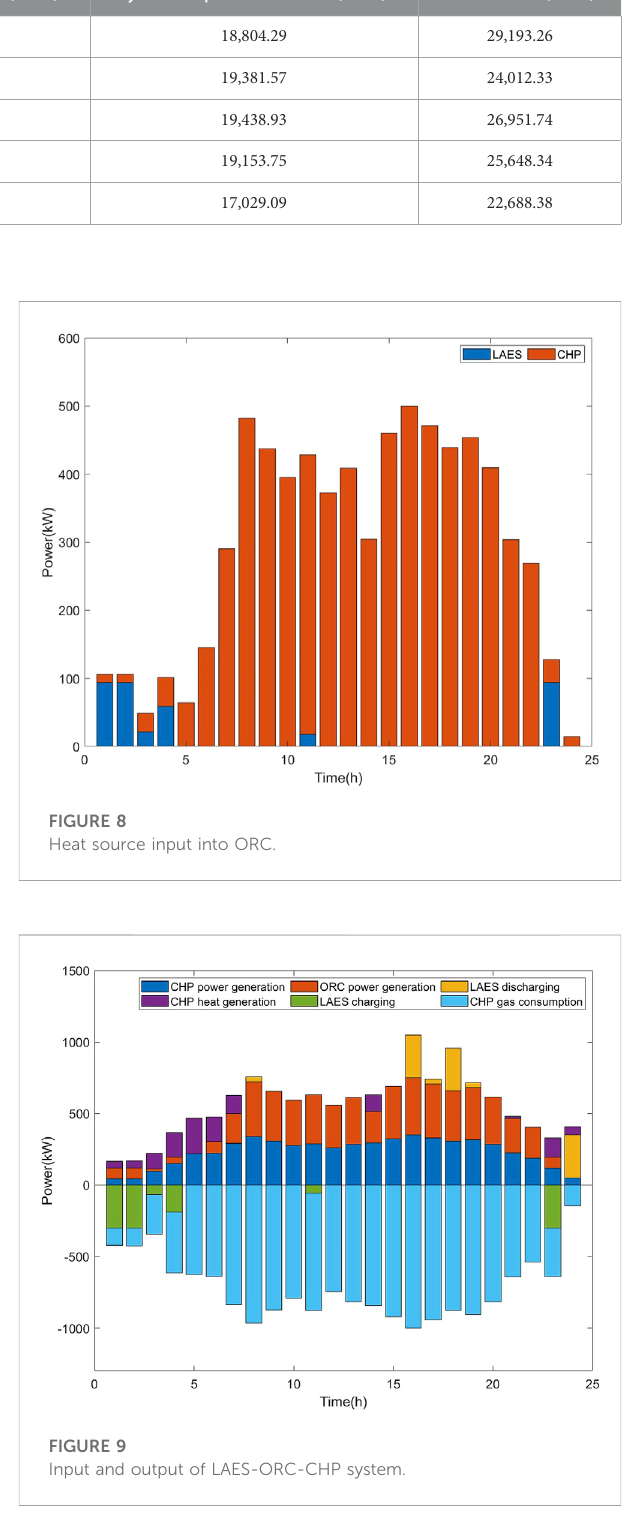
Figure 7. The sources of heat used by the ORC to generate electricity